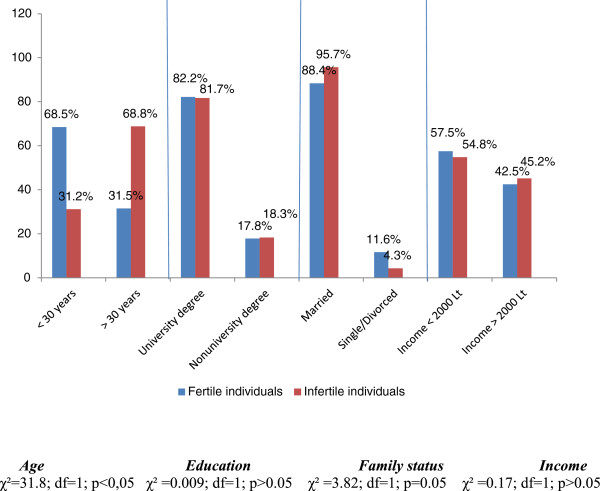
Socio-demographic characteristics of respondents.